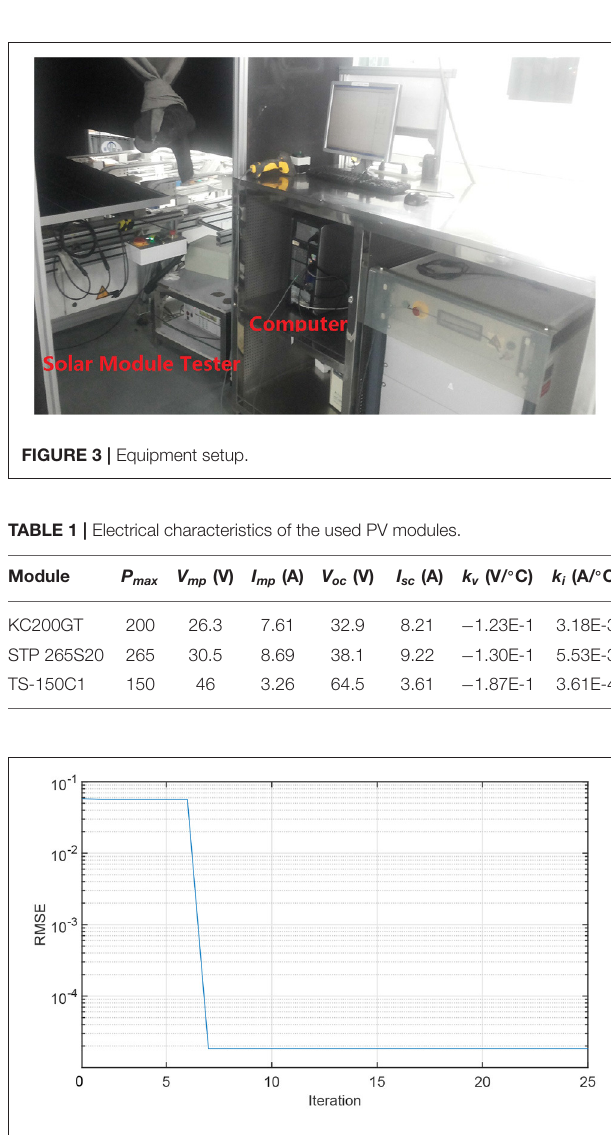
FIGURE 4 | Optimization process for a CS-RVM PV